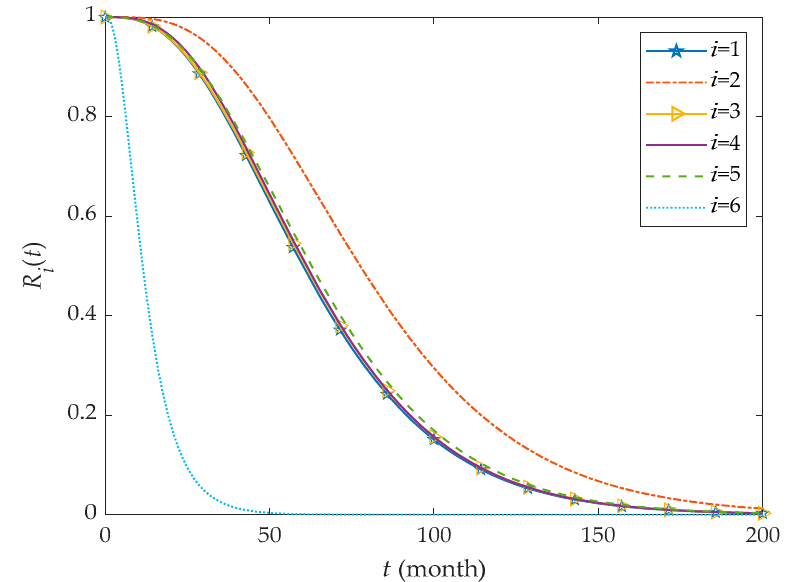
Figure 5. Reliability of each subsystem in the system.